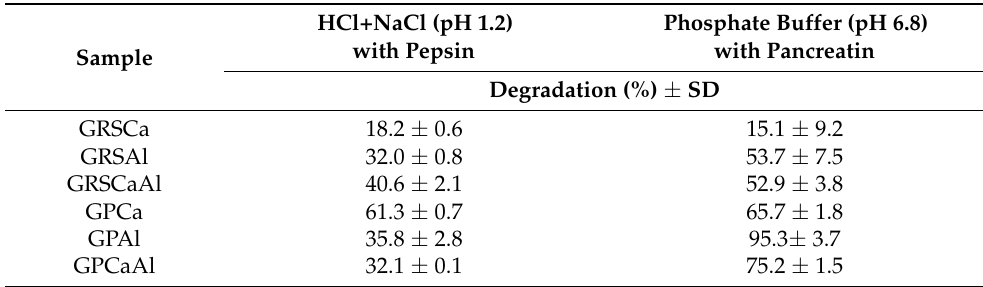
Table 3. Enzymatic degradation of the GG:P (GP) and GG:RS (GRS) microparticles cross-linked with Ca 2+ (Ca), Al 3+ (Al), or Ca 2+ and Al 3+ (CaAl). HCl+NaCl (pH Sample